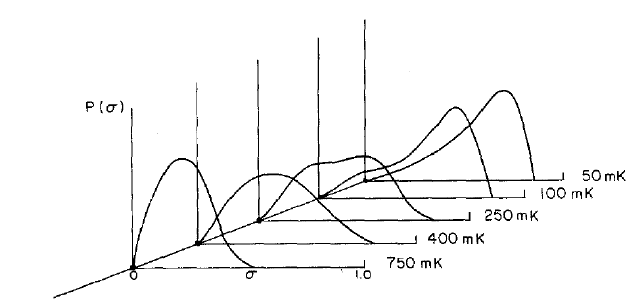
Figure 9. Temperature dependence of the probability distribution P ( σ ) for order parameters σ as deduced from observed NMR line shapes for solid hydrogen with ortho-H 2 concentrations of 23%. Reproduced with permission from [27]. Copyright Springer Nature,